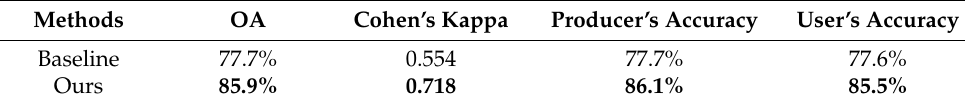
Table 4. Results in Changsha County.